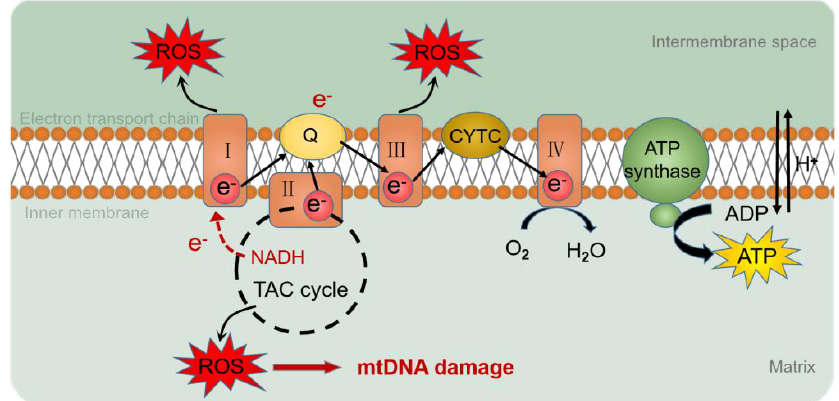
Figure 3. ROS production by the mitochondrial respiratory chain. During electron transfer in the mitochondrial respiratory chain, O 2 or H 2 O 2 is reduced to produce ROS. ROS accumulated in mitochondria cause oxidative damage to mtDNA. I: complex I; III: complex III; IV: complex IV; Q: ubiquinone; CYTC: cytochrome C; ROS: reactive oxygen species; e - : electron; NADH: nicotinamide adenine dinucleotide; TAC cycle: tricarboxylic acid cycle; O 2 : oxygen; H 2 O: hydrone; H + : hydrion.